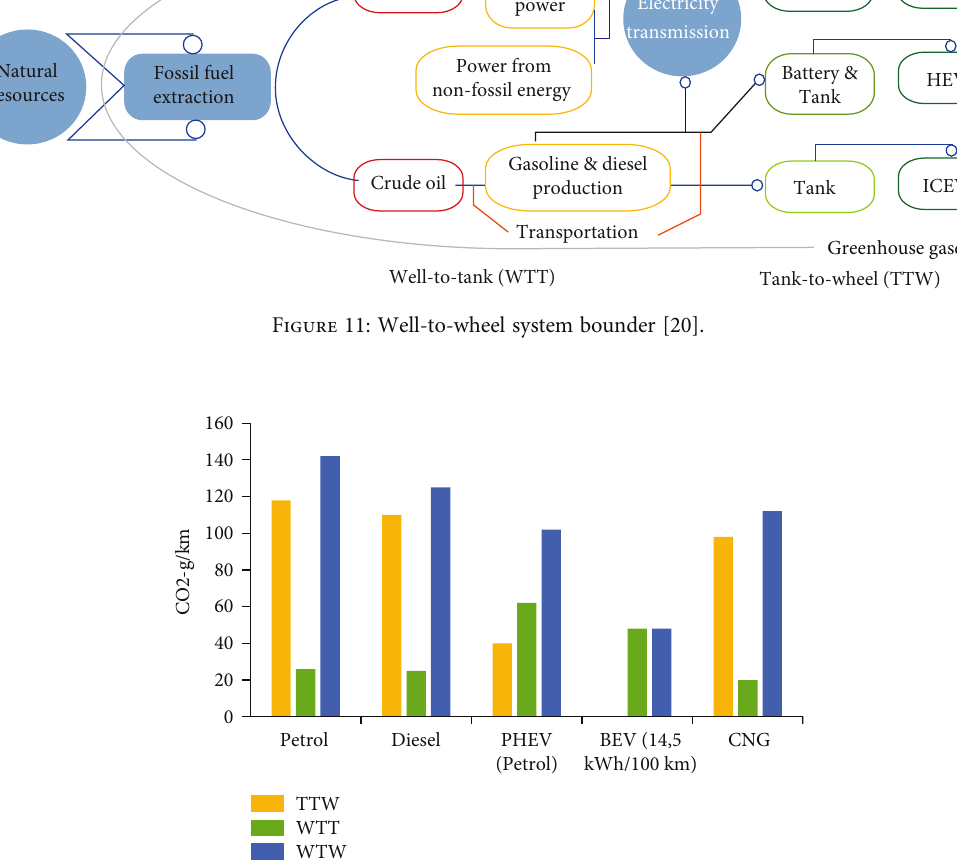
Figure 12: WTW emission comparison C-segment vehicle — WLTP